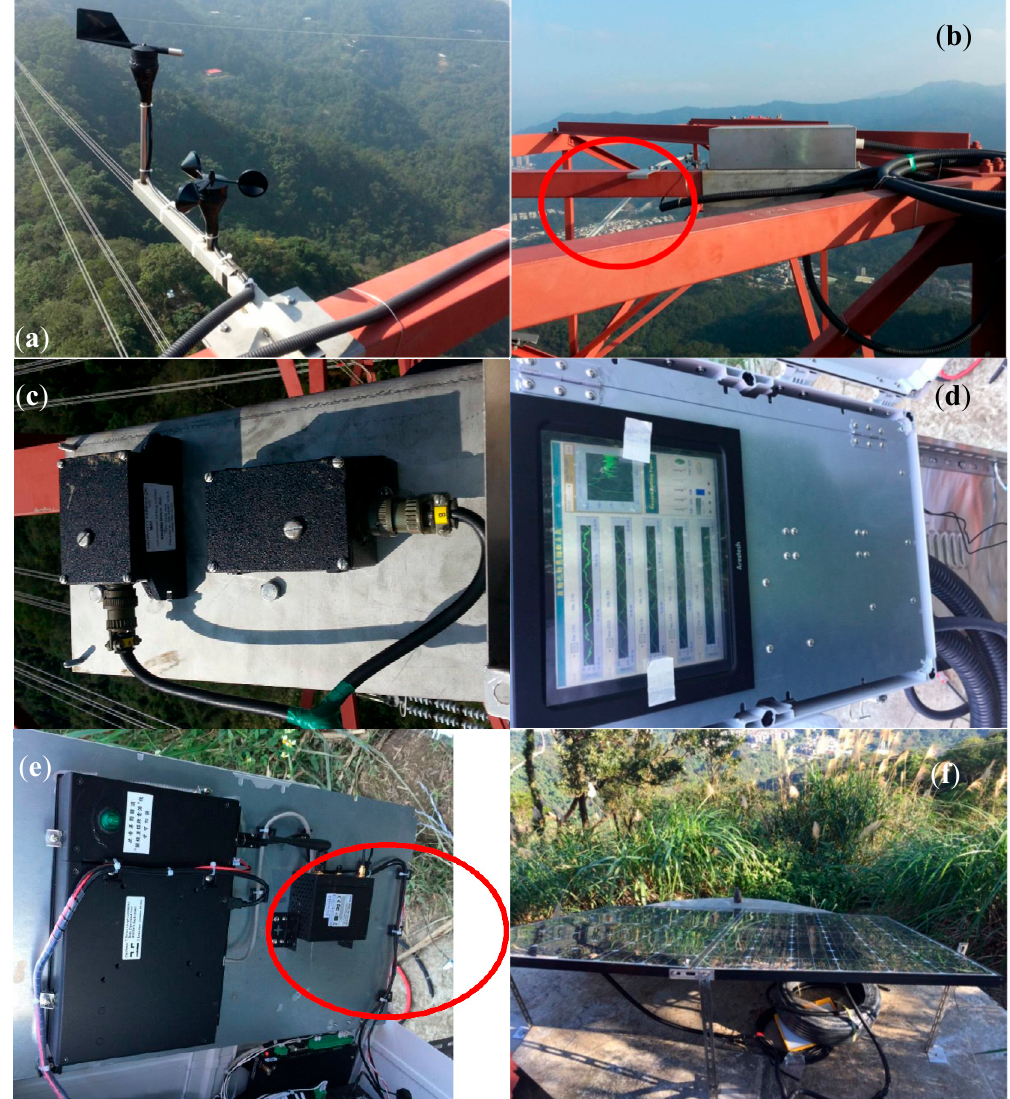
Figure 2. The monitoring system. ( a ) wind speed and wind direction sensors; ( b ) temperature sensor mounted on the component of PTT; ( c ) accelerometers; ( d ) data acquisition system with a monitor;( e ) 4G wireless router; ( f ) system power set.